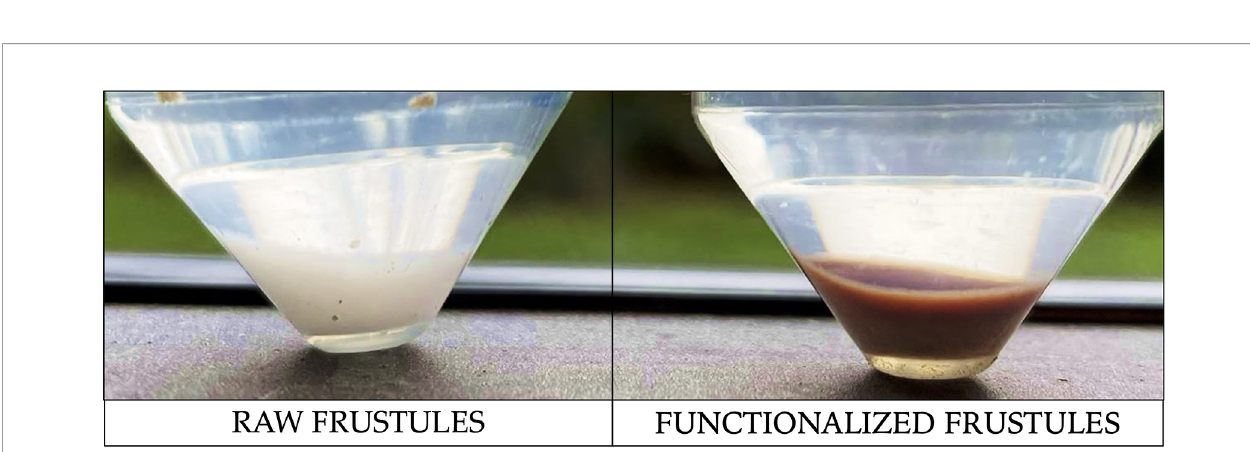
FIGURE 9 | Photograph of raw and functionalized frustules after 5 hours of Ni removal test. Dark coloration of functionalized frustules clearly indicates the interaction with